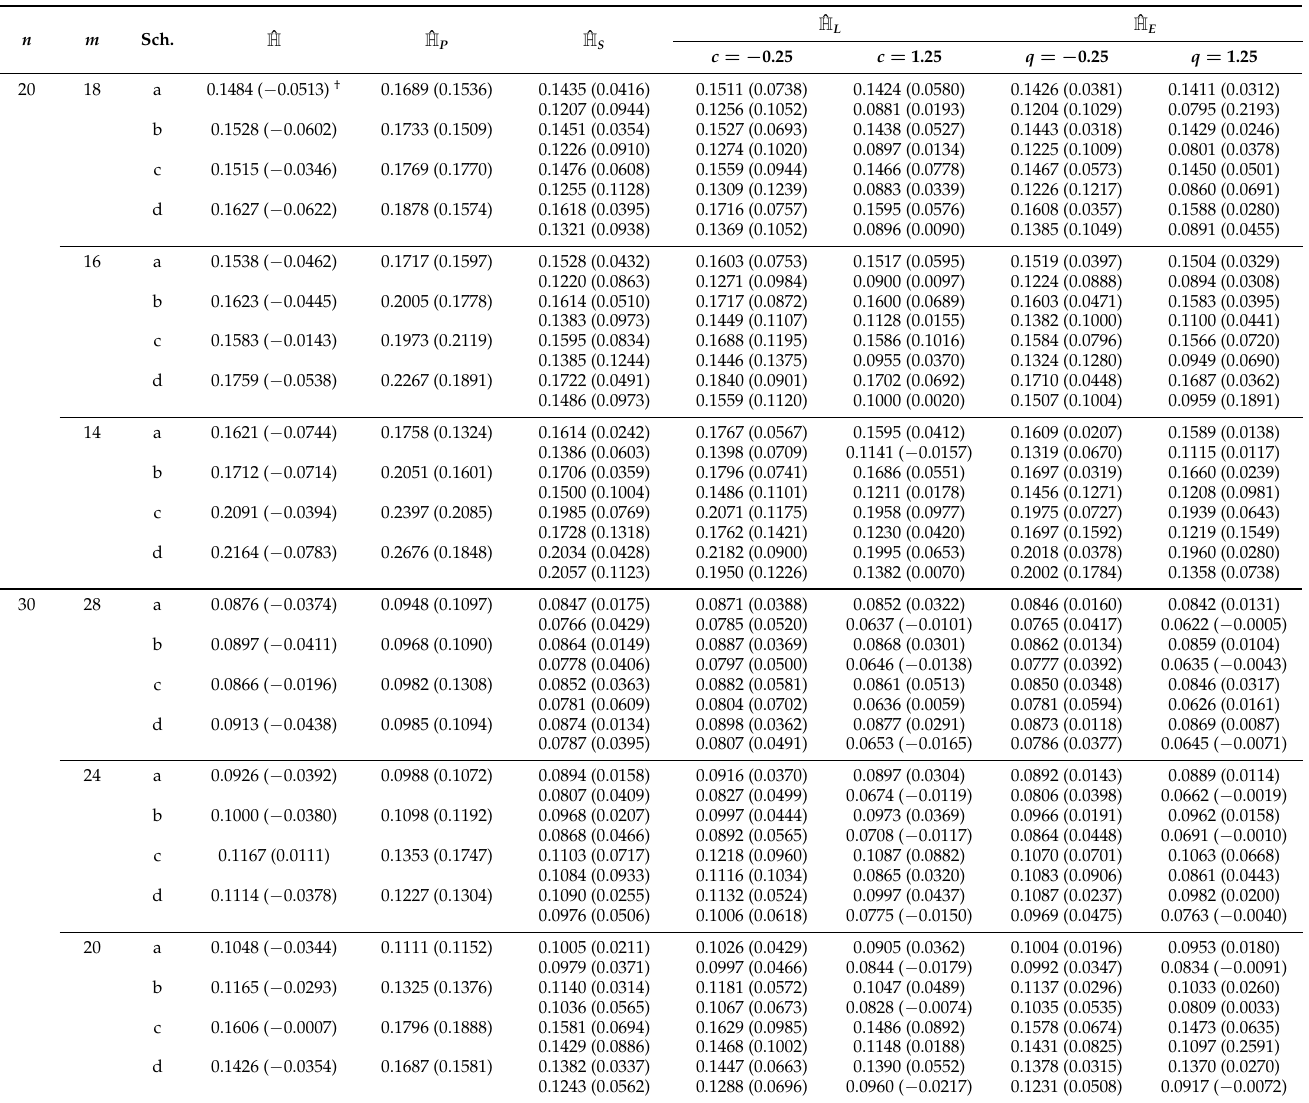
Table 2. The relative MSEs and biases of entropy estimators with classical and BayEst ( (cid:84) 1 = 1.5 and (cid:84) 2 =